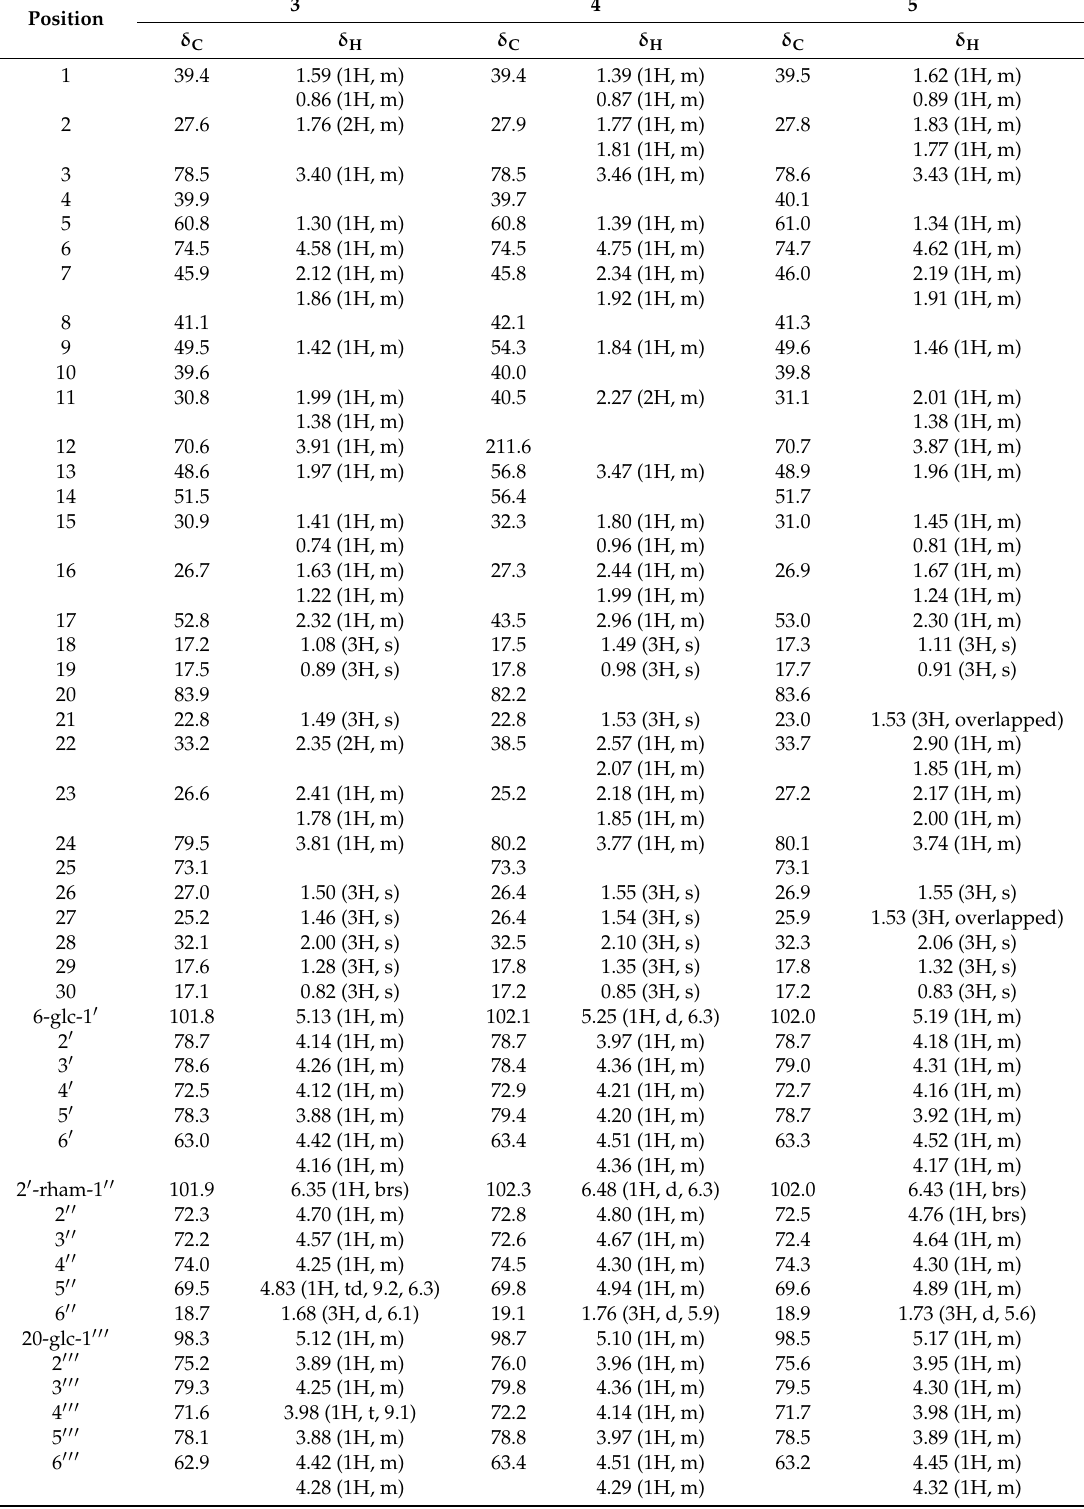
Table 2. 1 H and 13 C-NMR (600 MHz, 150 MHz in C 5 D 5 N) data for 3 – 5